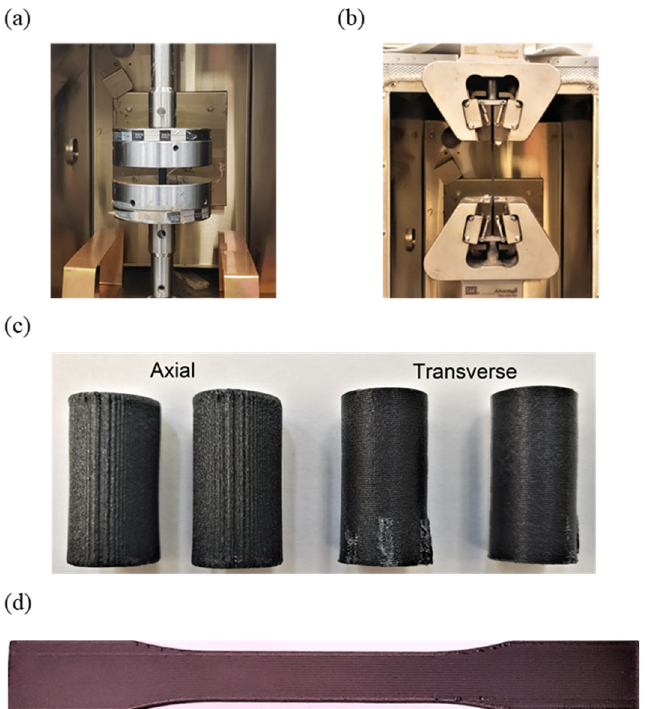
Figure 3 . Test Setup and Workpiece Quality ( a ) ASTM D695 Compression ( b ) ASTM D638 Tensile ( c ) Axial and Transverse Compressive Workpieces ( d ) Axial Tensile Workpiece .